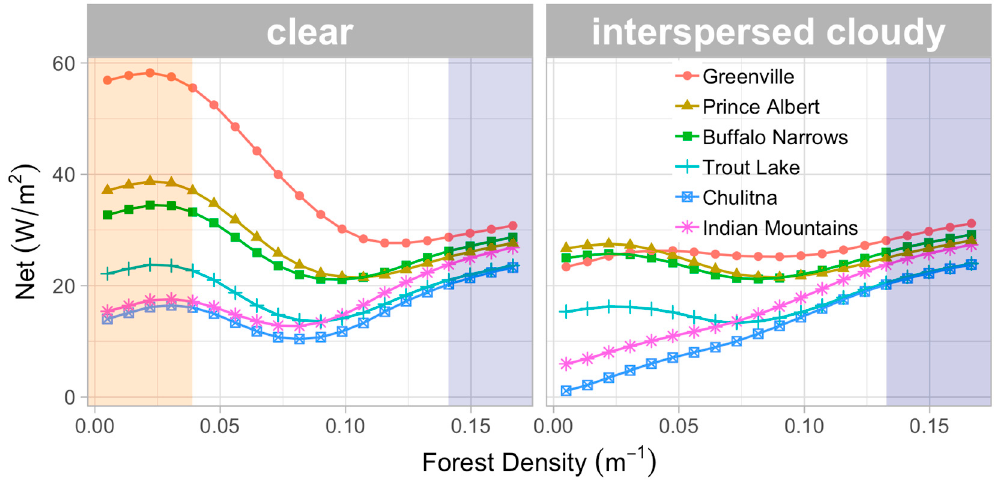
Figure 6. Variations of net radiation on level forests with vegetation density at different sites under clear and interspersed cloudy sky conditions. Sites are listed in increasing order of latitude. The orange and purple bands indicate the vegetation densities for which shortwave ( Δ S Net / Δ L Net > 5) and longwave ( Δ L Net / Δ S Net > 5) radiation components dominantly control the variation with latitude, respectively. Δ denotes the range of respective energy component for each site.